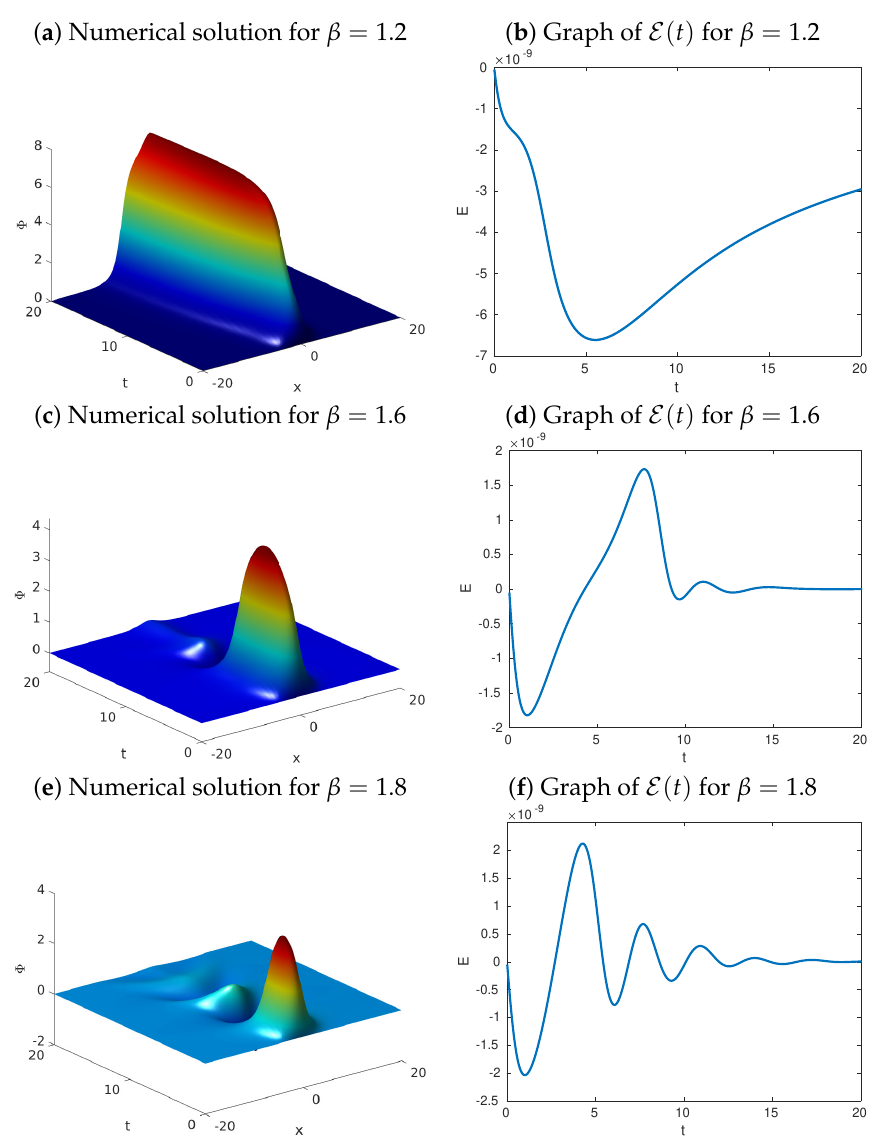
Figure 5. Left column: graphs of the numerical solution for the mathematical model (13). Right column: graphs of the approximate dynamics for the associated functional E . The parameters employed were α = 1.6, γ = 0 and F ( u ) = 1 − cos ( u ) , for each u ∈ R . Moreover, we used β = 1.2 (top row), β = 1.6 (middle row) and β = 1.8 (bottom row). We employed the finite-difference method (42) with Ω = ( − 20,20 ) and T = 20. Computationally, we let h = 0.5 and τ =